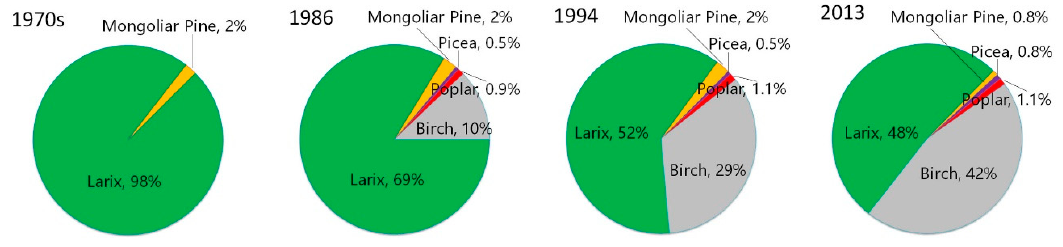
Figure 3. Area of tree species in 1970, 1986, 1994 and 2013.